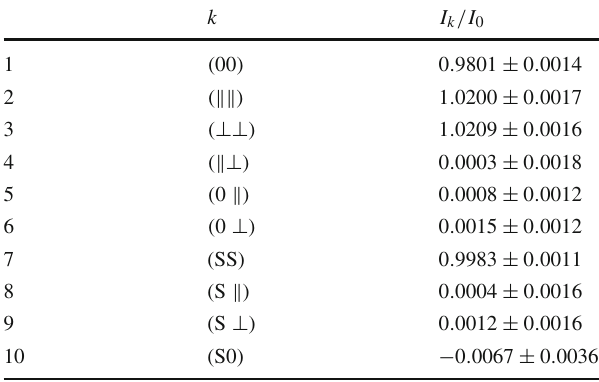
Table 2 Angular acceptance integrals for the simulated sample. The I k integrals are normalised with respect to the I 0